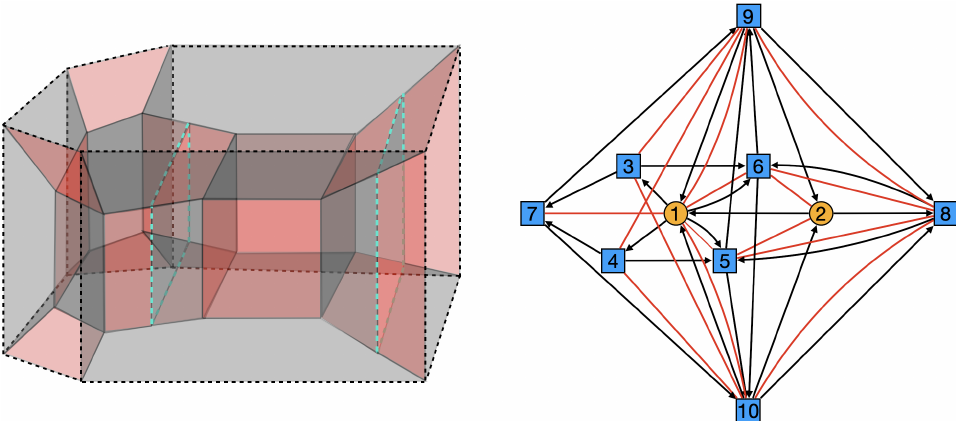
Figure 27 . Model obtained by acting with triality on node 2 of the one in Figure